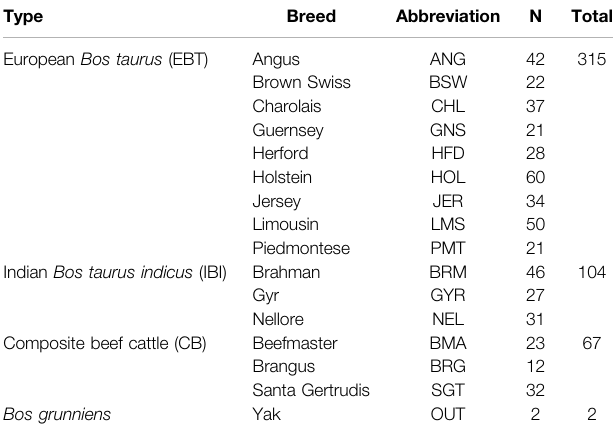
TABLE 1 | Descriptive statistics for the studied cattle